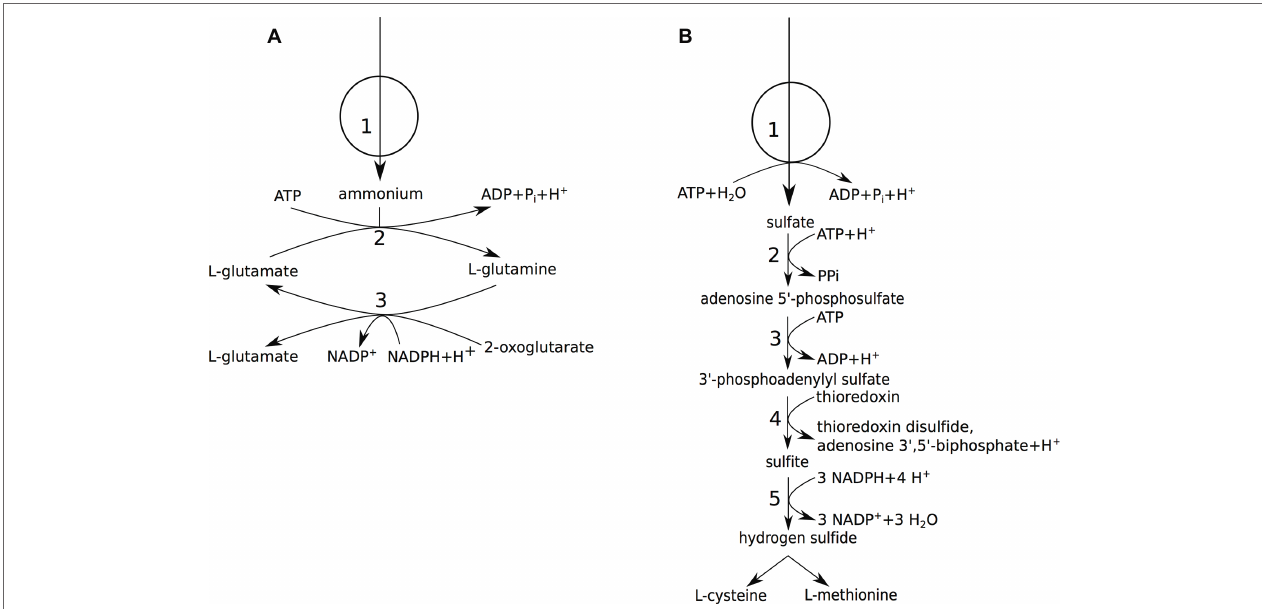
FIGURE 3 | Nitrogen and sulfur metabolism of A. pasteurianus 386B. (A) Ammonium assimilation. (1) ammonium permease; (2) glutamine synthetase (EC 6.3.1.2); (3) glutamate synthase (NADPH-dependent) (EC 1.4.1.13). (B) Sulfate assimilation. (1) sulfate ABC transporter; (2) sulfate adenylyltransferase (EC 2.7.7.4); (3) adenylyl-sulfate kinase (EC 2.7.1.25); (4) phosphoadenylyl-sulfate reductase (thioredoxin-dependent) (EC 1.8.4.8); (5) assimilatory sulfite reductase (NADPH-dependent) (EC